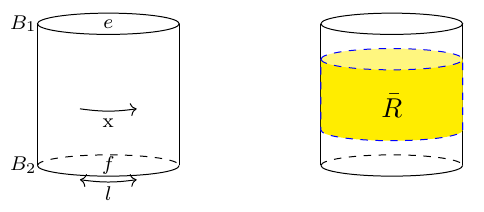
Figure 14 . Entanglement entropy of a cylindrical region embedded in a cylinder.